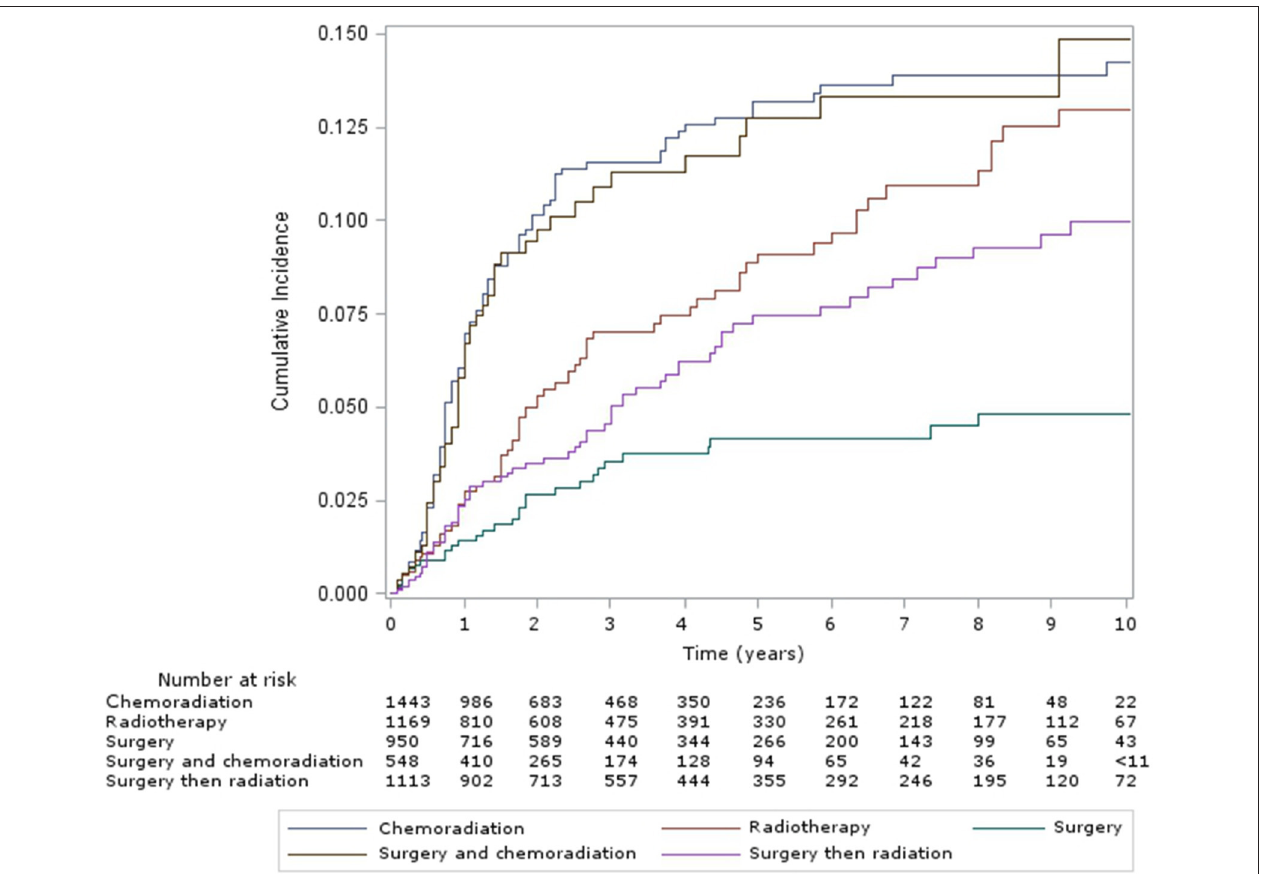
FIGURE 1 | Cumulative incidence of esophageal dilation in all sites, by treatment group.